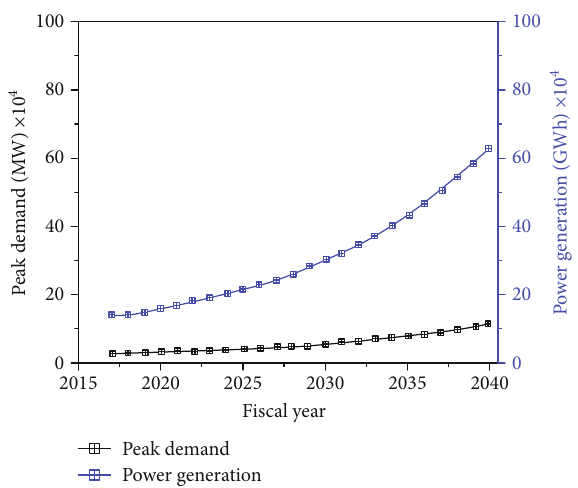
Figure 3: Future load forecasting of the peak demand and installed capacity.